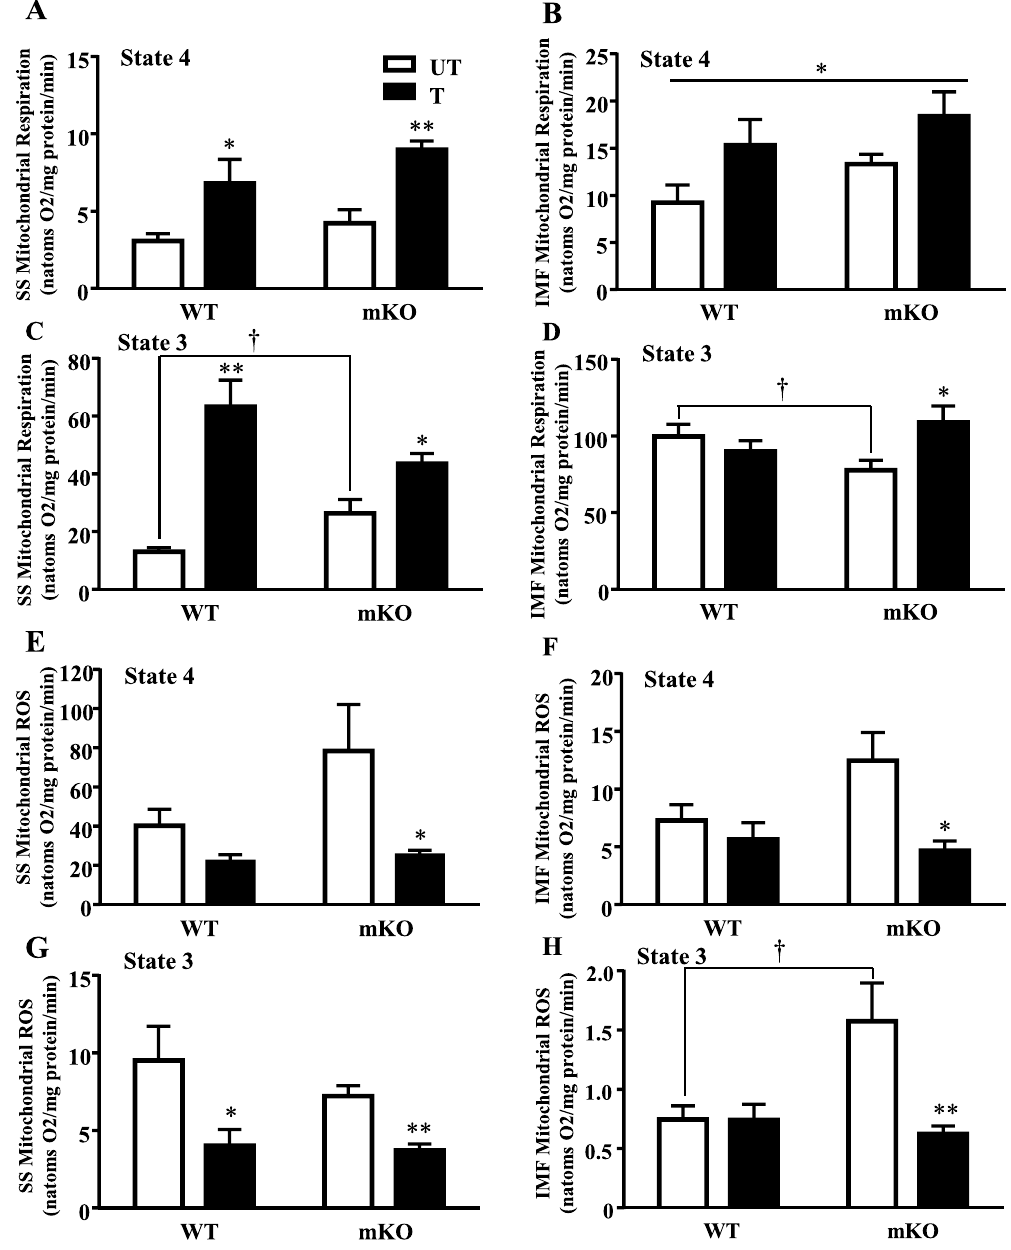
Figure 3. Mitochondrial respiration improves with exercise training while ROS is reduced. State 4 respiration was measured in ( A ) SS (n = 6–7/group); * p ≤ 0.05, ** p ≤ 0.01, UT vs. T, Student’s t-test and 2-way ANOVA, and ( B ) IMF mitochondria (n = 6–7/group); * p ≤ 0.05, main effect of genotype and training, 2-way ANOVA. State 3 respiration was further measured in ( C ) SS (n = 6/group); * p ≤ 0.05, ** p ≤ 0.01, UT vs. T, Student’s t-test and 2-way ANOVA; † p ≤ 0.05, UT WT vs. mKO, Student’s t-test, and ( D ) IMF mitochondria (n = 6–7/group); * p ≤ 0.05, UT vs. T; † p ≤ 0.05, UT WT vs. mKO, Student’s t-test. State 4 ROS levels were measured in ( E ) SS, and ( F ) IMF mitochondria (n = 6–8/group); * p ≤ 0.05, UT vs. T, 2-way ANOVA. State 3 ROS levels were measured in ( G ) SS, and ( H ) IMF mitochondria (n = 6–8/group); * p ≤ 0.05, ** p ≤ 0.01, UT vs. T, Student’s t-test and 2-way ANOVA; † p ≤ 0.05, UT WT vs. mKO, 2-way ANOVA. Data are presented as mean ±